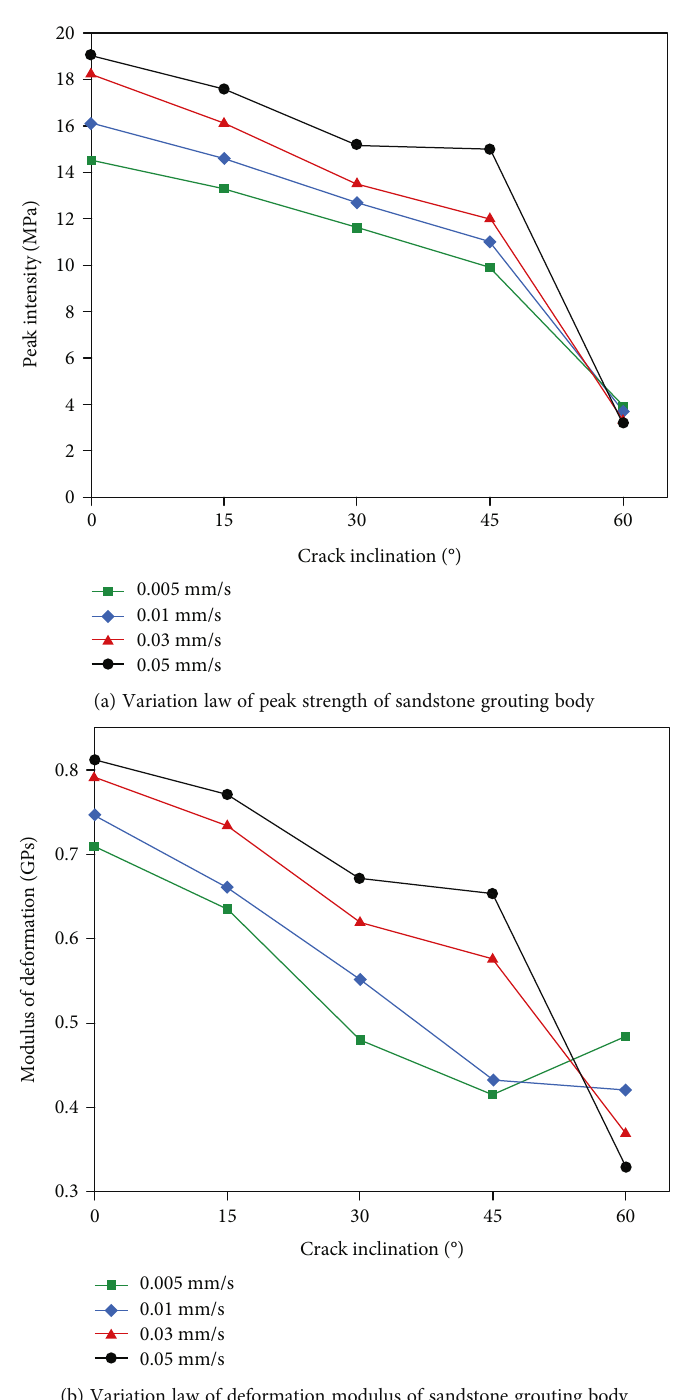
Figure 6: Variation curves of mechanical properties of grouting materials under di ff erent loading